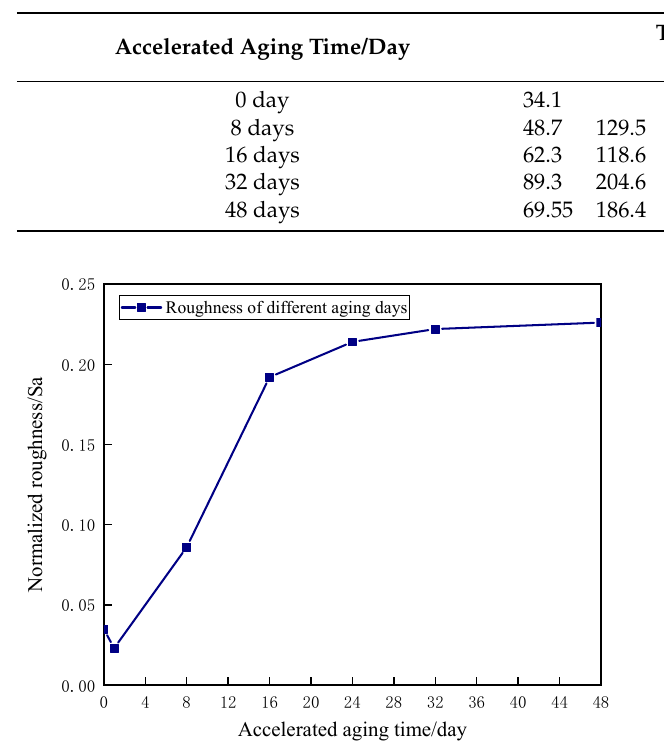
Figure 6. The surface roughness changes with time.